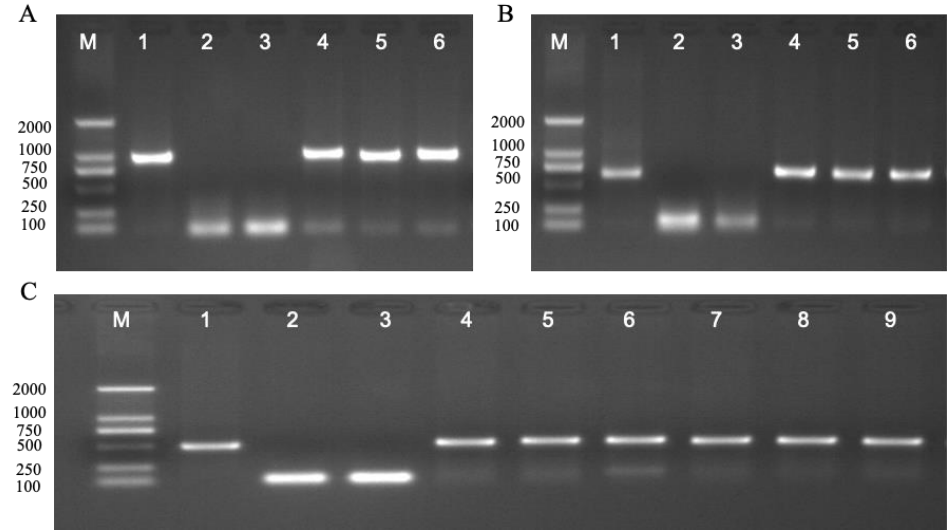
Figure 1. PCR analysis of the transgenic lines and WT lines. ( A ) Specific primers PsnWRKY70 -F and PsnWRKY70 -R for amplifying the full length of PsnWRKY70 ORF, overexpression positive plas- mid (lane 1), WT lines DNA (lane 2), water (lane 3), OE1 (lane 4), OE2 (lane 5), OE3 (lane 6). ( B ) PsnWRKY70 interference specific primers pRS300-F/pRS300-R, l PsnWRKY70 interference expres- sion positive plasmid (lane 1), WT lines DNA (lane 2), water (lane 3), RE1 (lane 4), RE2 (lane 5), RE3 (lane 6). ( C ) Primers nptII-F and nptII-R, DL2000 DNA marker (M), PsnWRKY70 overexpression positive plasmid (lane 1), WT (lane 2), water (lane 3), OE1 (lane 4), OE2 (lane 5), OE3 (lane 6), RE1 (lane 7), RE2 (lane 8), RE3 (lane 9).